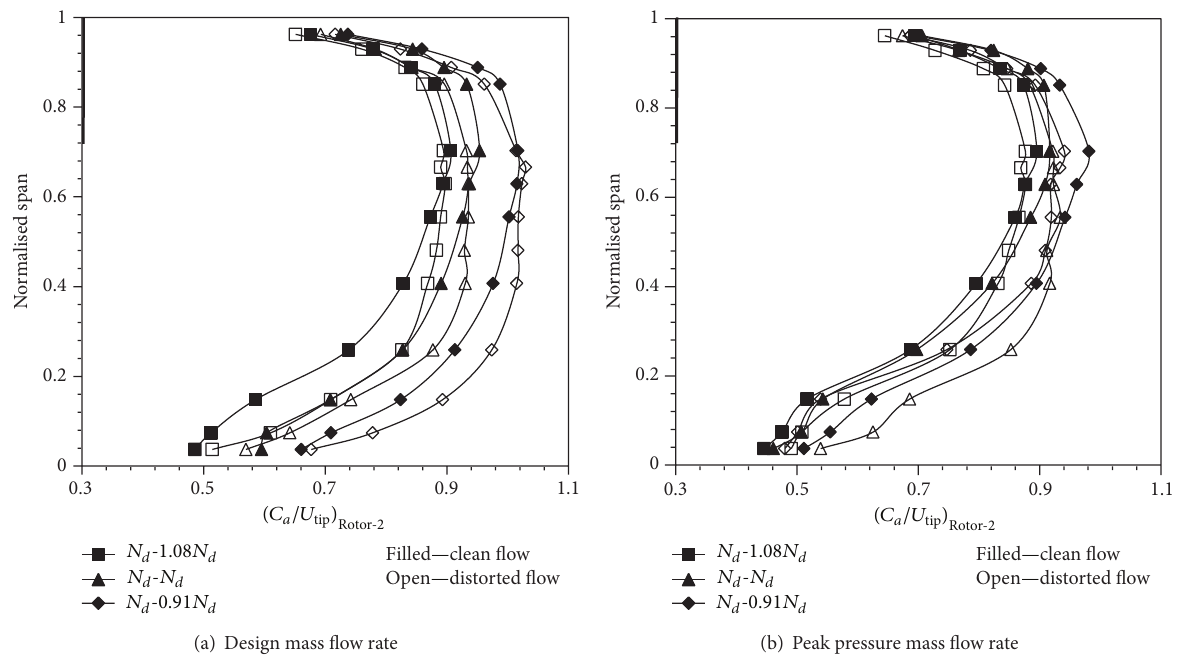
Figure 14: Spanwise variation of axial velocity ratio at the exit of rotor-2.